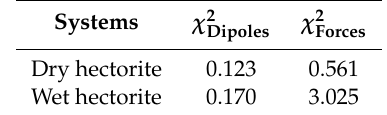
Table 3. Parameters of the PIM force field for the interactions between lithium and the other atoms. The parameters C ij , C ij and b ij n between Li and O are equal to the interactions O OH -X (with X = Al, 6 8 Mg, Si, O or O OH ) [34]. The repulsion and dispersion interactions between Li and the other cations are negligible because the electrostatic repulsion predominates. As lithium polarizability is negligible, the polarization potential is restricted to the interactions between the charge of Li and the dipoles of polarizable ions.